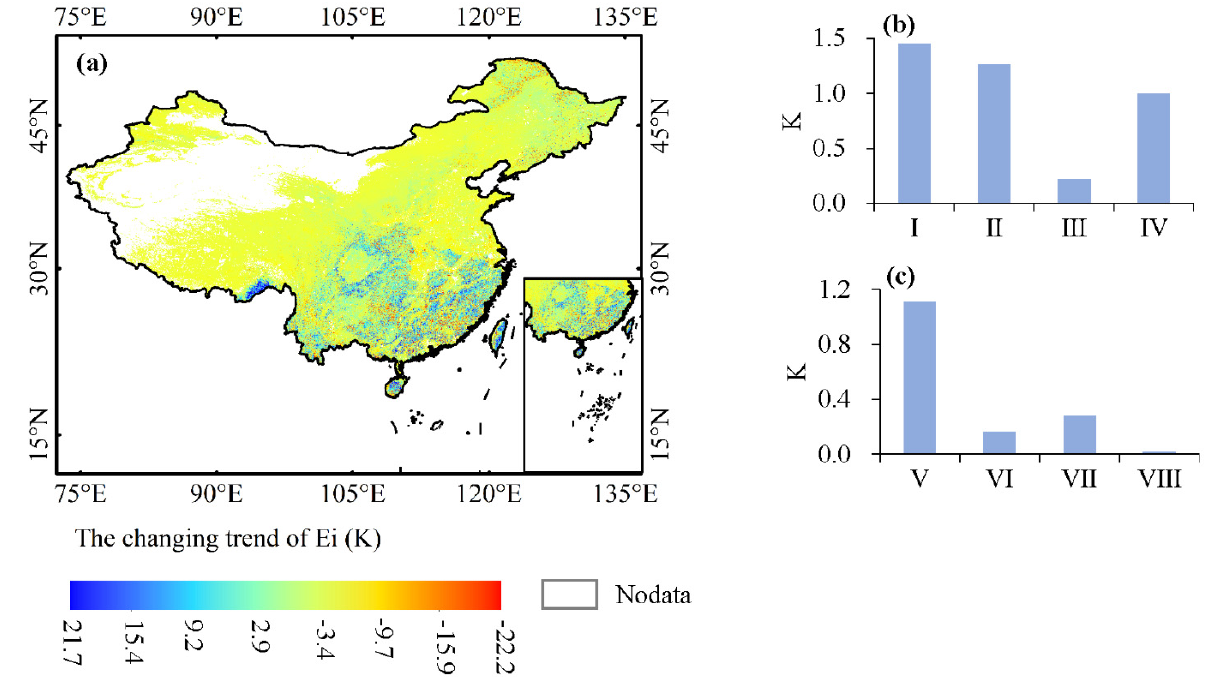
Figure 5. The spatial distribution of Ei changing trend across China during 2001 − 2020. ( a ) The spatial distribution of changing trend (K); ( b ) the average K of different thermal regions. I, II, III, and IV are tropical regions, subtropical regions, temperate regions, and plateau climate regions, respectively; ( c ) the average K of different moisture regions. V, VI, VII, and VIII are humid regions, semi-humid regions, semi-arid regions, and arid regions, respectively.